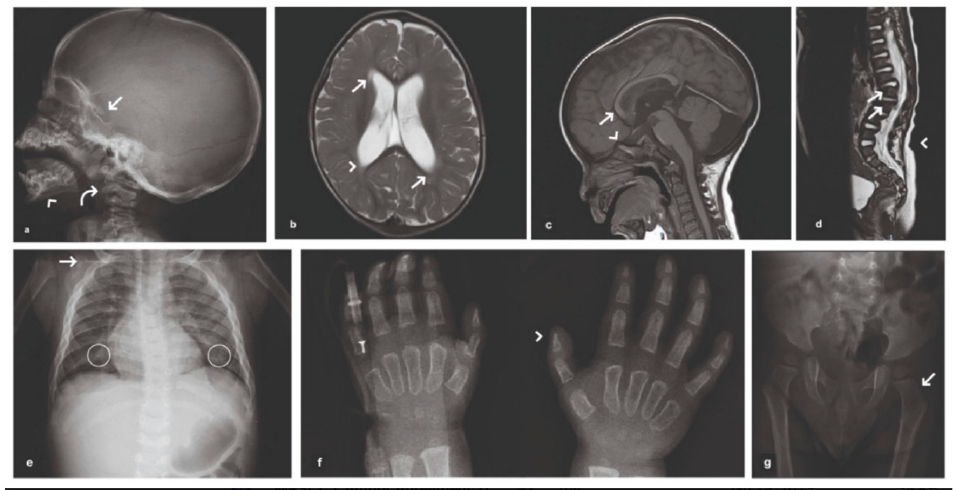
Figure 2. Index patient’s X-ray images. ( a ) Lateral skull X-ray: macrocephaly with abnormal J-shaped sella turcica (arrow); molars unerupted and angulated in both jaws (arrowhead); C2 odontoid process hypoplasia (curved arrow). ( b ) MRI T2: patched hyperintensity areas (arrows); Evans’ index of 0.3; fourth ventricle dilatation (arrowhead). ( c ) MRI T1: thin corpus callosum (arrow); sella turcica dysplasia (arrowhead). ( d ) MRI T2: L1-L2 dysplasia (arrow); exuberant kyphotic curve (arrowhead). ( e ) Anterior posterior chest X-ray: perihilar infiltrate and peribronchial thickening (circles). ( f ) Anterior posterior hand plate X-ray: cone-shaped phalanges (arrowhead). ( g ) Pelvic X-ray: bilateral coxa vara (arrow).